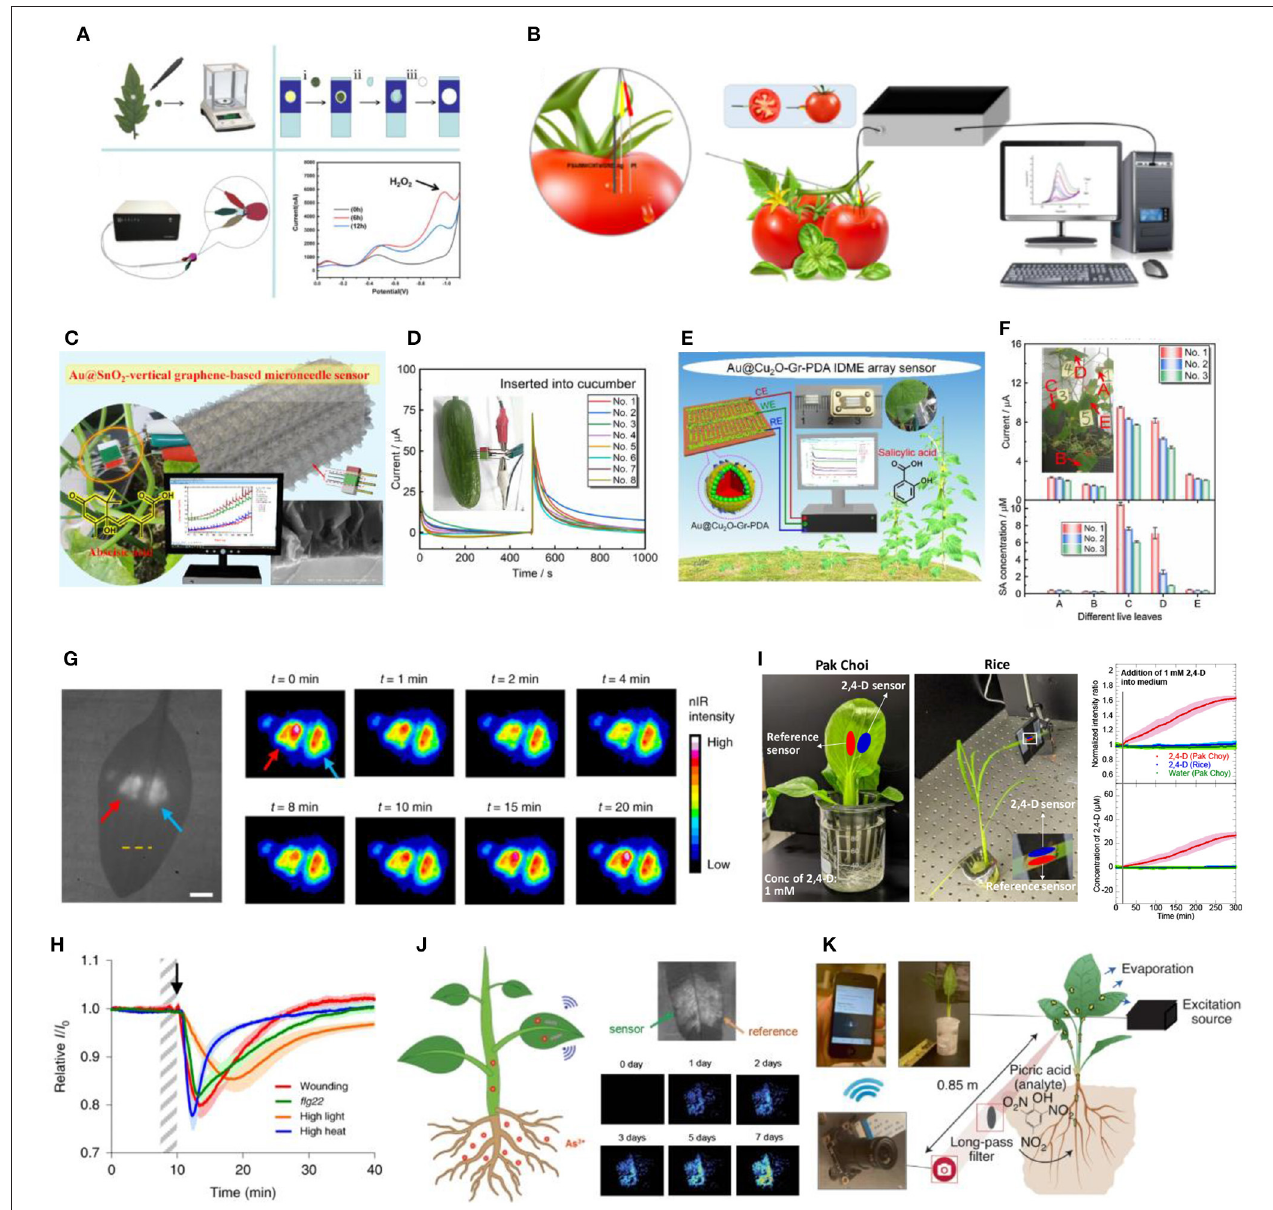
FIGURE 1 | (A) Paper-based electro-analytical device used in detection of H 2 O 2 in circular plant samples punched out of the tomato leaves (Sun et al., 2020); (B) Miniaturized electrochemical sensor inserted into tomato fruits for detection of auxin precursor, Tryp (Yang et al., 2021); (C) in situ ABA electrochemical sensor assembled onto a microneedle array for detection in fruits (Wang et al., 2021); (D) Current-time curves generated when the ABA microneedle sensor is inserted into cucumber where ABA concentrations is linearly correlated with the step current observed (Wang et al., 2021); (E) in situ SA electrochemical sensor arranged in an IDME array for insertion into cucumber leaves (Liu et al., 2021); (F) Response current (top) and derived SA concentration (bottom) obtained from the IDME array sensor in 5 different live cucumber leaves (Liu et al., 2021); (G) Brightfield (left) and corresponding false-colored images (right) of a spinach leaf infiltrated with H 2 O 2 (red arrow) and reference (blue arrow) nanosensors on both sides of the leaf mid-vein. False-colored images shows the transient H 2 O 2 wave upon mechanical wounding of the leaf at t = 0min (Lew et al., 2020b); (H) H 2 O 2 nanosensor response to different types of stress applied to the plant, including mechanical wounding (red), flg22 treatment (green), high light (orange) and high heat (blue) stresses (Lew et al., 2020b); (I) Real-time sensing of 2,4-D uptake in hydroponically grown pak choi and rice leaves using nanosensors which illustrated a turn-on response observed in pak choi but not in rice over a time-period of 5h (Ang et al., 2021); (J) Arsenite nanobionic sensor infiltrated into hyperaccumulator plant Pteris creticas fern, showing intensity changes corresponding to arsenic accumulation detected over 7-day time period upon arsenite exposure (Lew et al., 2021); (K) Schematic of standoff detection of nitroaromatic compound, picric acid, using nanosensors with real-time information relayed from the nanosensor-infiltrated plant to a portable Raspberry Pi-based electronic device (Wong et al., 2017).